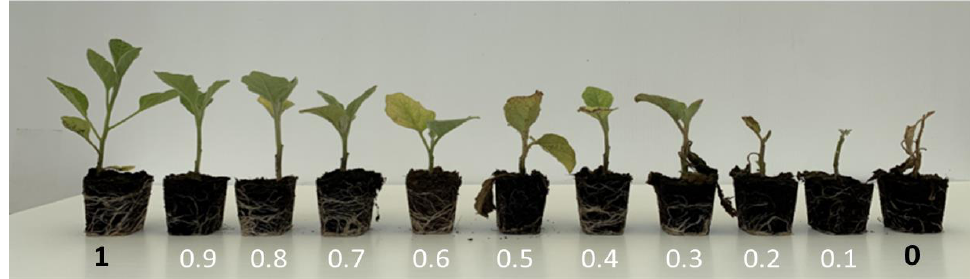
Figure 1. Visual representation of the degree of symptoms assigned to each single plant, ranging from 1 to 0.